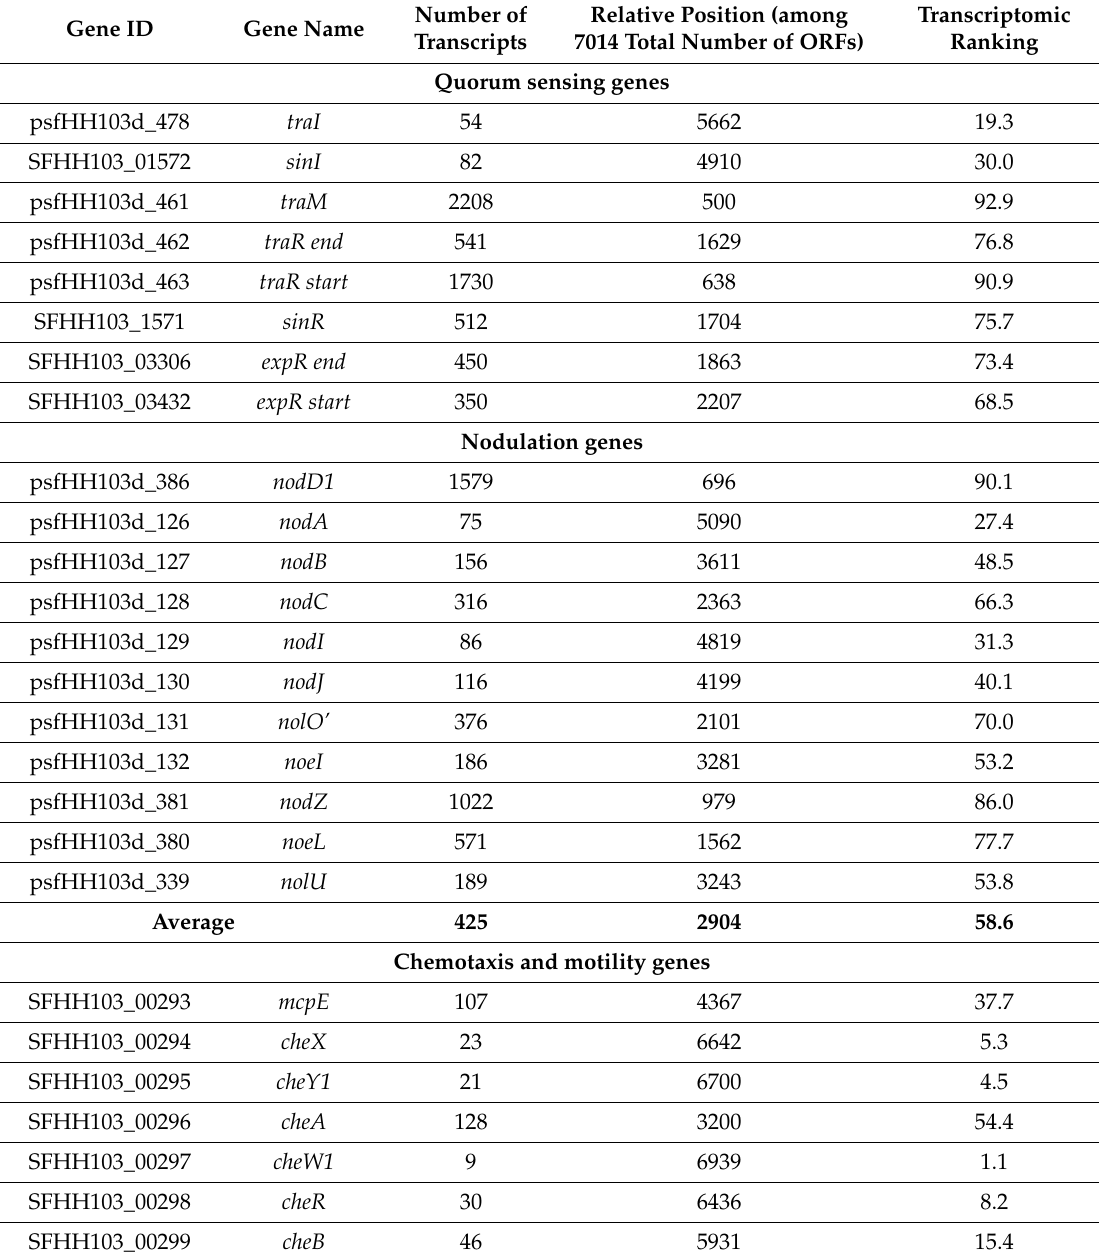
Table 4. Number of transcripts assigned to putative quorum sensing (QS)-regulated genes of S. fredii HH103 and transcriptional ranking in yeast extract mannitol (YM) medium at stationary phase in the absence of inducing